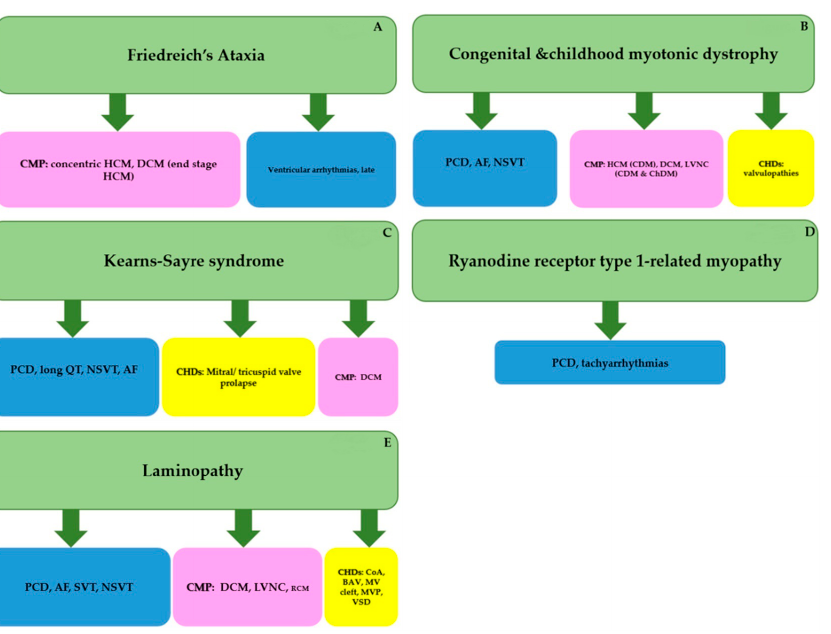
Figure 1. Pediatric cardiac manifestations of the described NMDs in order of their frequency as reported in literature: A: Friedreich’s Ataxia (FRDA); B: Congenital Myotonic Dystrophy (CDM) and Childhood Myotonic Dystrophy (ChDM); C: Kearn Sayre Syndrome (KSS); D: RYR1 -RM, ryanodine receptor type 1-related myopathy; E: Laminopathies. Abbrevia- tions: AF, atrial fibrillation; AVB, atrioventricular block; BAV, bicuspid aortic valve; CHDs: congenital heart defects; CMP, cardiomyopathy; CoA, aortic coarctation; DCM, dilated cardiomyopathy; HCM, hypertrophic cardiomyopathy; LVNC, left ventricular non compaction ; MV, mitral valve; MVP, mitral valve prolapse; NSVT, non-sustained ventricular tachy- cardia; PCD, progressive conduction defect; RCM, restrictive cardiomyopathy; SCD, sudden cardiac death; SND, sinus node dysfunction; SVT, supraventricular arrhythmias.